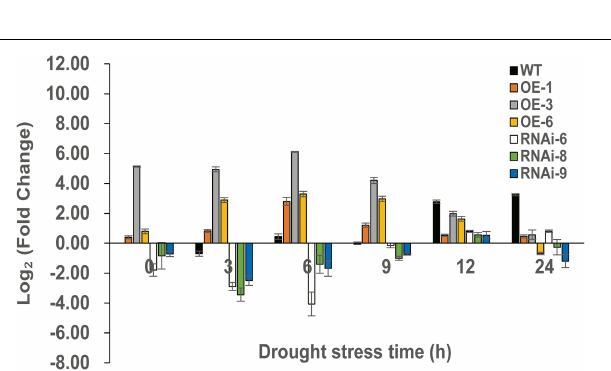
FIGURE 8 | Relative expression of TaNRX1 in different lines of transgenic wheat under different drought stress times. Data represent the mean ± SD ( n = 3). WT, wild type; OE-1–OE-6, TaNRX1 overexpression T 3 homogeneous lines; RNAi-6–RNAi-9, TaNRX1 RNA interference T 3 homogeneous